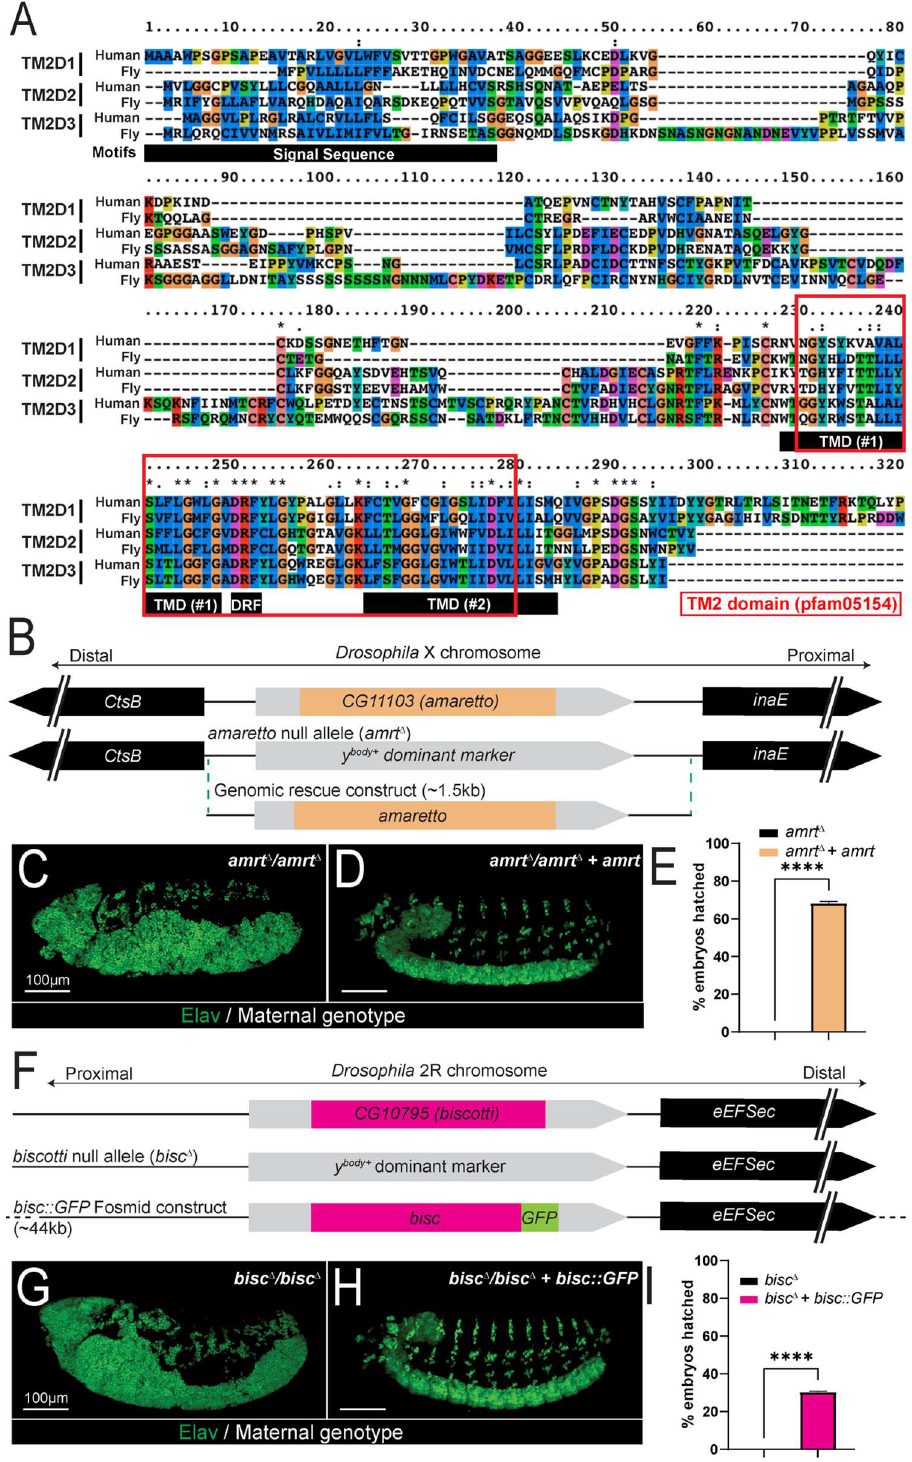
Fig 2. Null alleles of fly orthologs of TM2D2 ( CG11103/amrt ) and TM2D1 ( CG10795/bisc ) phenotypically mimics the loss of TM2D3 ( amx ). (A) Protein alignment of human and Drosophila TM2D proteins. The TM2 domain (boxed in red) is composed of two transmembrane domains (TMD) and an intracellular DRF motif (denoted by black bars for TM2D3). (B) Schematic of amaretto ( amrt ) locus, amrt null allele ( amrt Δ ), and amrt genomic rescue plasmid construct